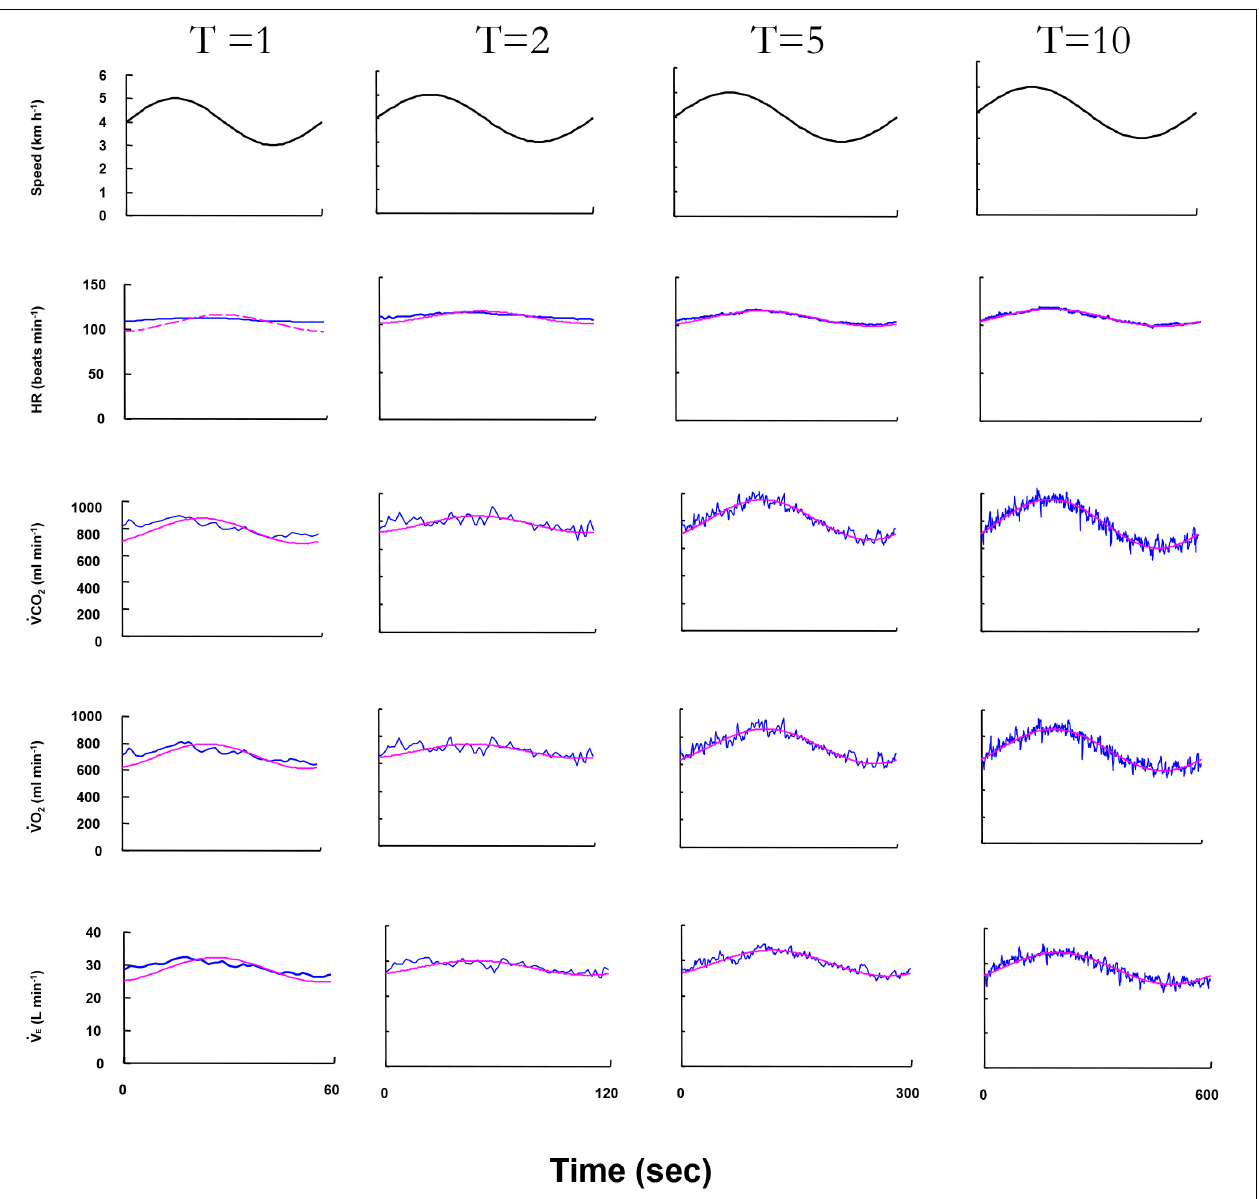
FIGURE 2 | The cardiorespiratory variables of ventilation (˙V E ), O 2 uptake (˙VO 2 ), CO 2 output (˙VCO 2 ), and heart rate (HR) responses to four different treadmill speed oscillation during 1-, 2-, 5-, and 10-min periods in a representative elderly subject. Oscillating line: superimposed gas exchange variables data. Smooth line: sine-wave fundamental component of these kinetics. The HR response at the 1-min period could not be estimated by Fourier